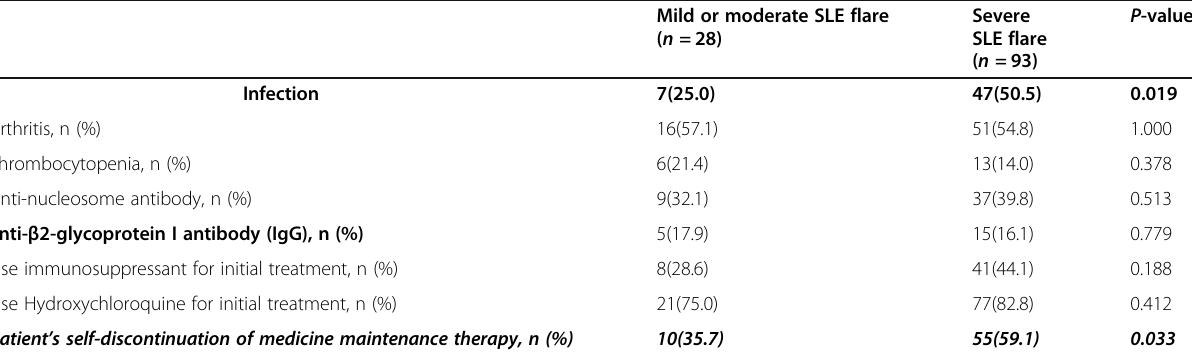
Table 4 The occurrence of risk factors in different degrees of SLE